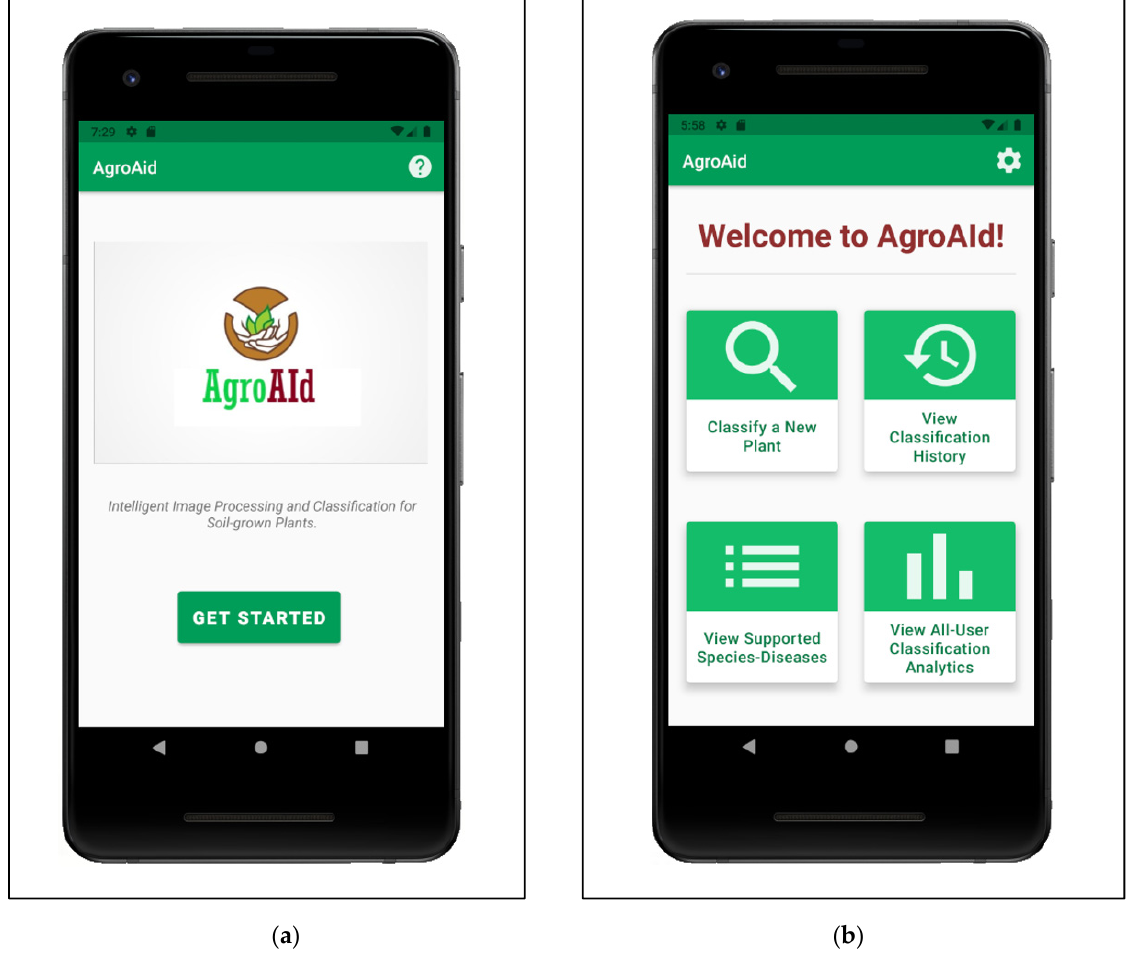
Figure 25. ( a ) Home page of the mobile application; ( b ) Central activity of the mobile application displaying all of the system’s implemented functionalities.